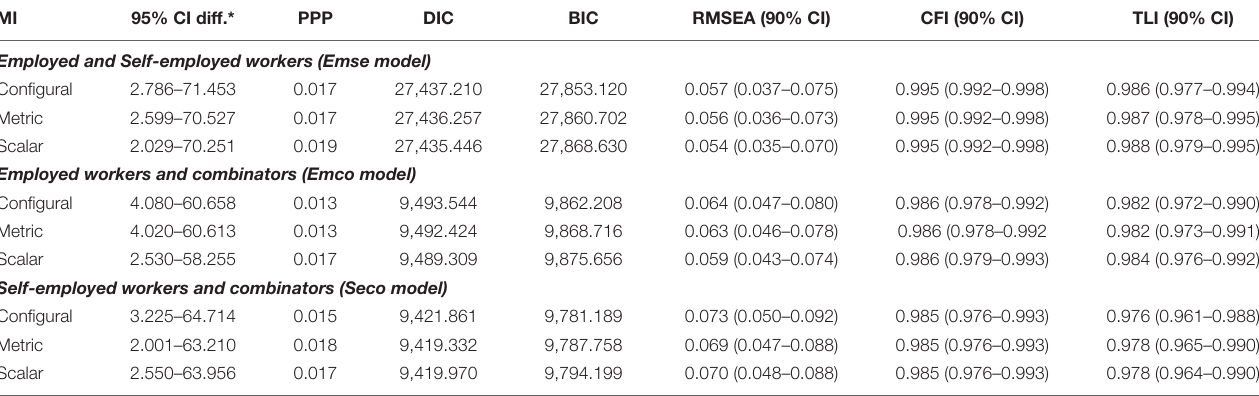
TABLE 4 | Measurement invariance analyses: Depressive symptoms.